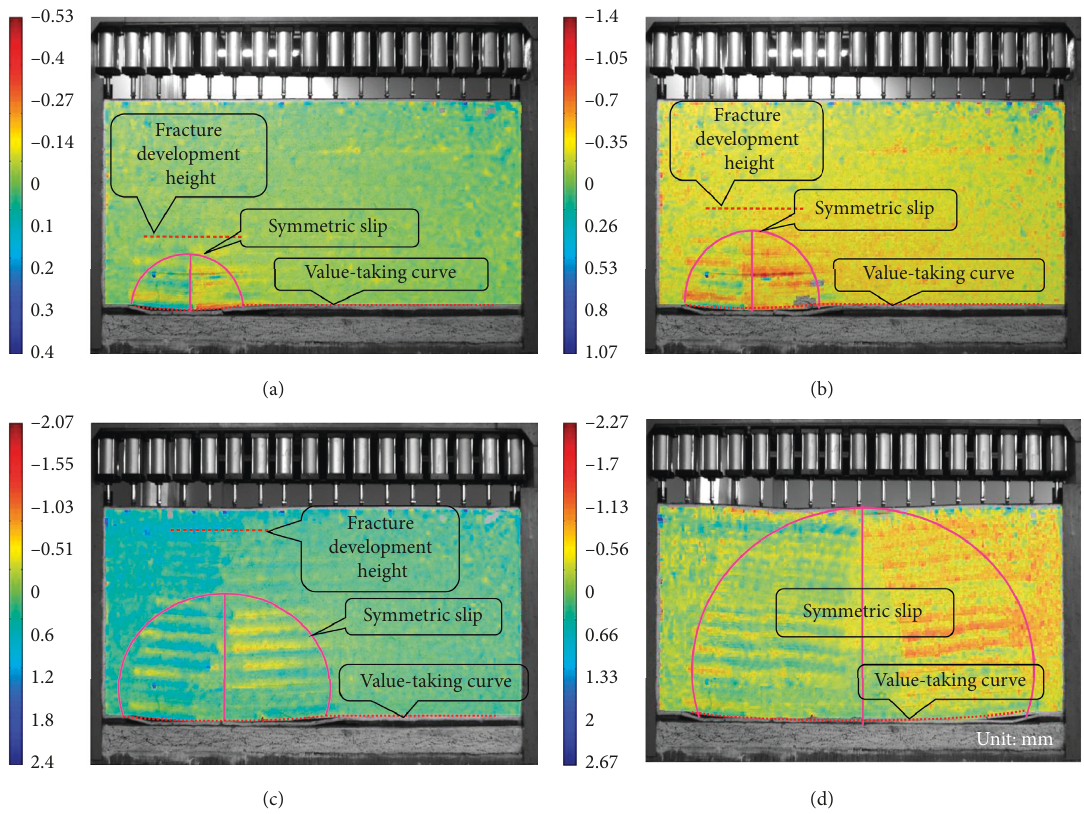
Figure 12: Horizontal slip contour plots in the working face with different advance distances: (a) 78 m, (b) 117m, (c) 160m, and (d) vertical directions. The horizontal length of the slip is the same as that of the overburden bedding plane fissures. The vertical length of the slip is shorter than the height of the vertical fissures. According to field measurement, the horizontal fissures are shorter than the vertical fissures.